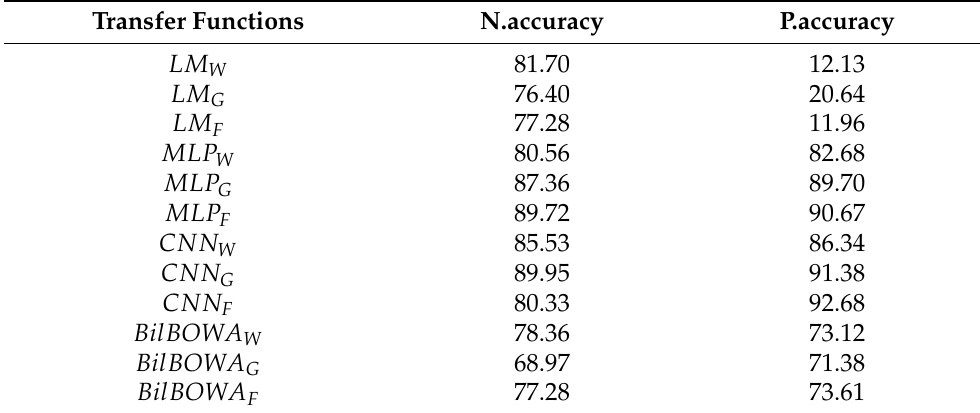
Table 3. Neighborhood and Pairwise Accuracy (N.accuracy and P.accuracy) of English–Tamil TFGE trained on various models. LM, MLP, and CNN refers to the transfer function learning models, Linear Mapping, Multi Layer Perceptron, and Convolutional Neural Network, respectively. The subscripts W, ,G and F refer to the vector training algorithms, Word2Vec, GloVe, and FastText, respectively.